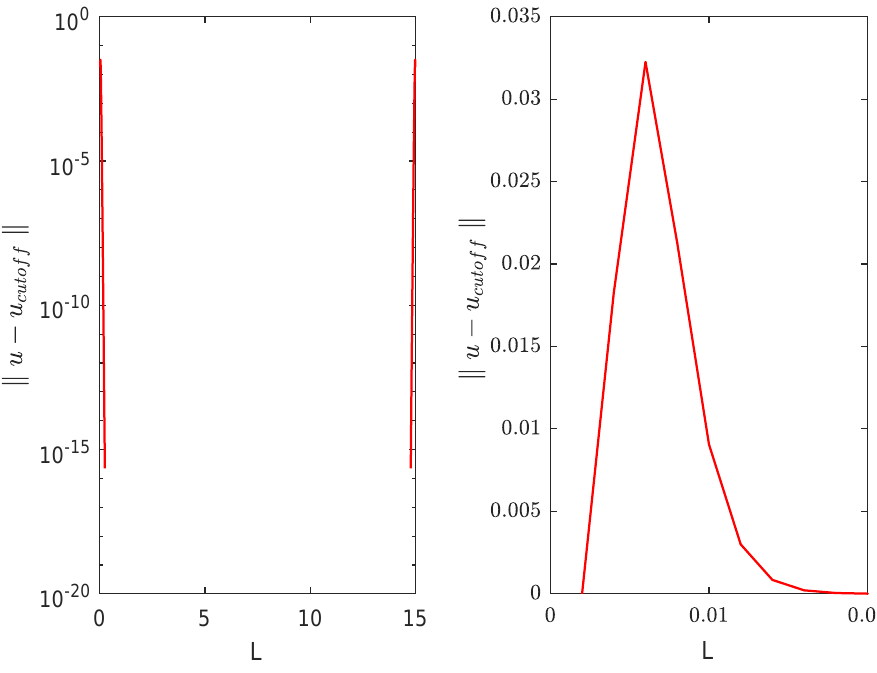
Figure 5. Distribution of the error (cid:107) u − u cutof f (cid:107) over space at t = 0.5, i.e., immediately after the cutoff was implemented. ( left ) distribution over the whole domain 0 < x < L ; ( right ) a magnified view of the part of the domain close to the left-hand side